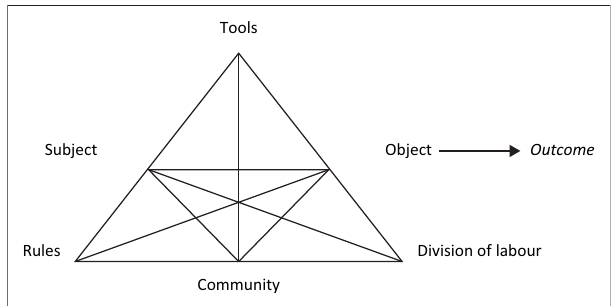
FIGURE 1: Activity theory